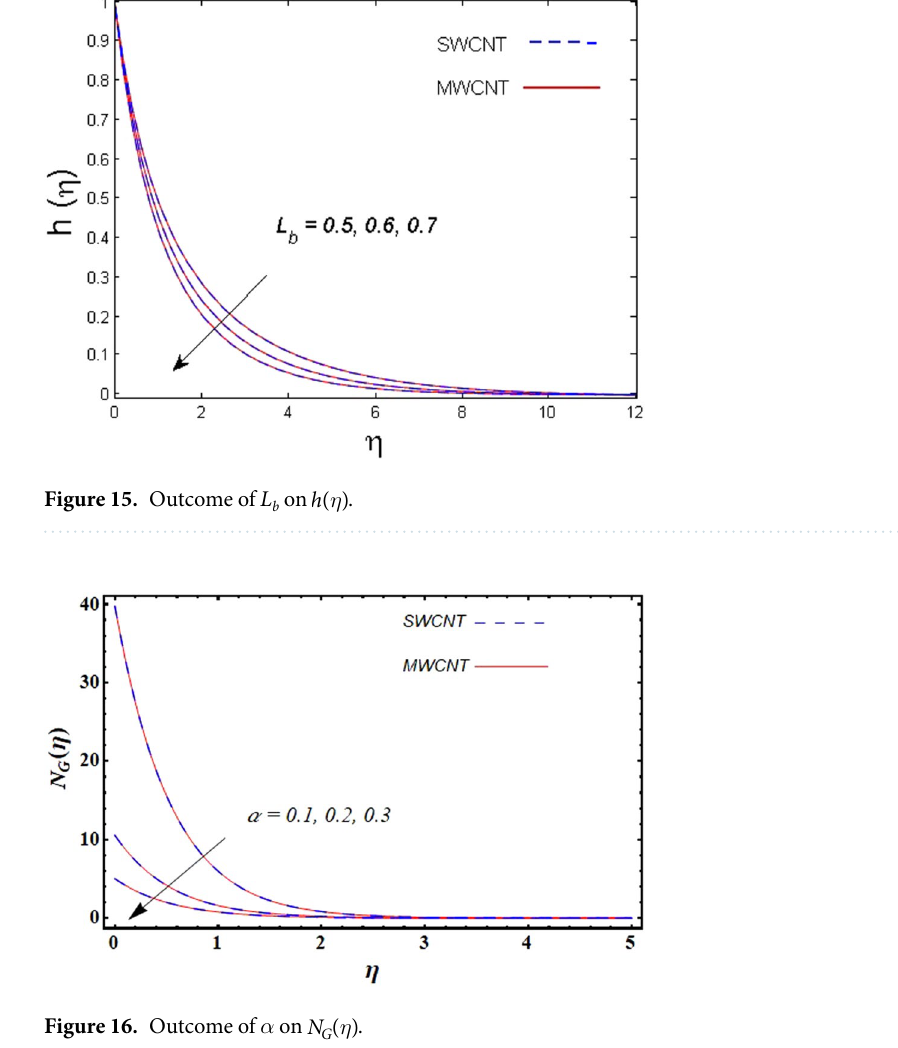
Figure 16. Outcome of α on N ( )